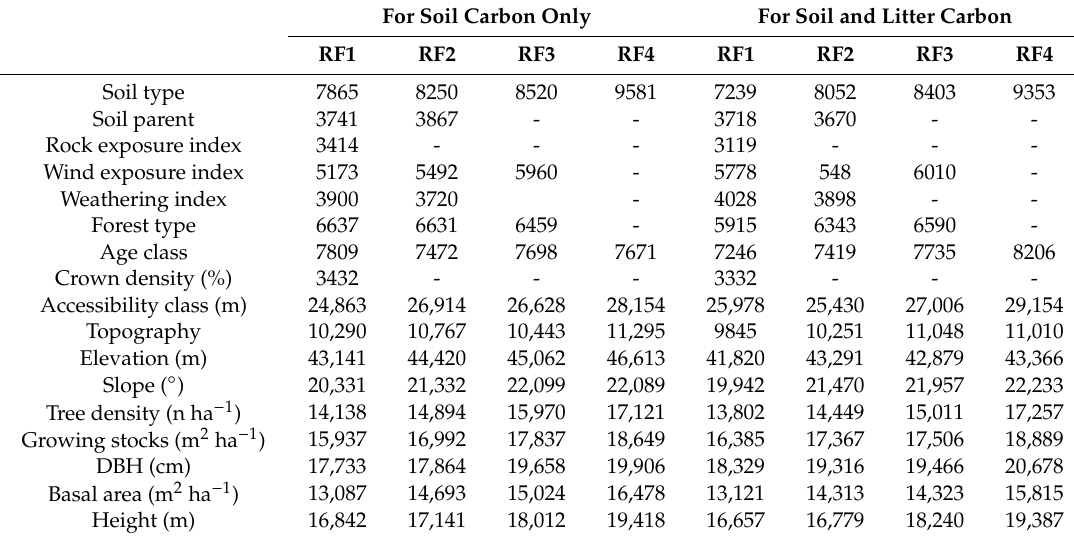
Table 4. Variable importance from training data set of the four random forest (RF) models.